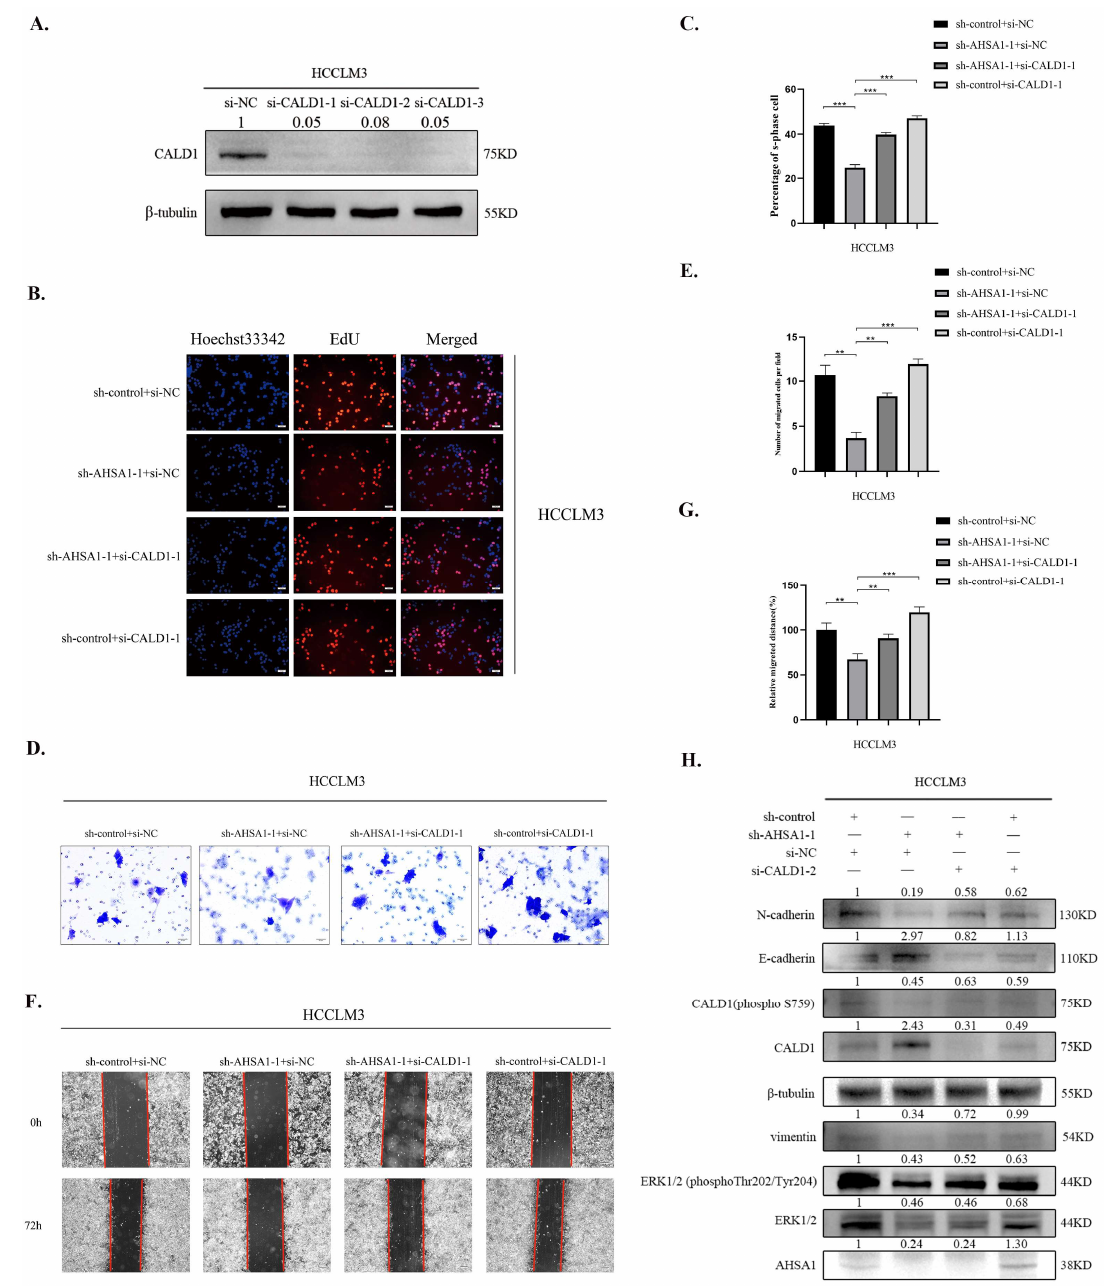
Figure 6. Inhibition of CALD1 expression reversed the inhibition of proliferation and EMT in HCC by knockdown of AHSA1 ( A ). The efficiency of CALD1 knockdown in HCCLM3 cells was detected by Western blot. ( B , C ). Representative images and quantitative analysis of EdU imaging showed that knockdown of AHSA1 significantly inhibited HCC proliferation, which could be reversed by CALD1 silencing. ( D – G ). Representative images and quantitative analysis of Transwell and wound healing assays showed knockdown of AHSA1 led to decreased HCC invasion and migration, which could be reversed by CALD1 silencing. ( H ). The changes in protein expression after inhibiting CALD1 expression in HCCLM3 cells with AHSA1 knockdown were detected by Western blot. **, p < 0.01; ***, p < 0.001. The uncropped blots are shown in Supplementary